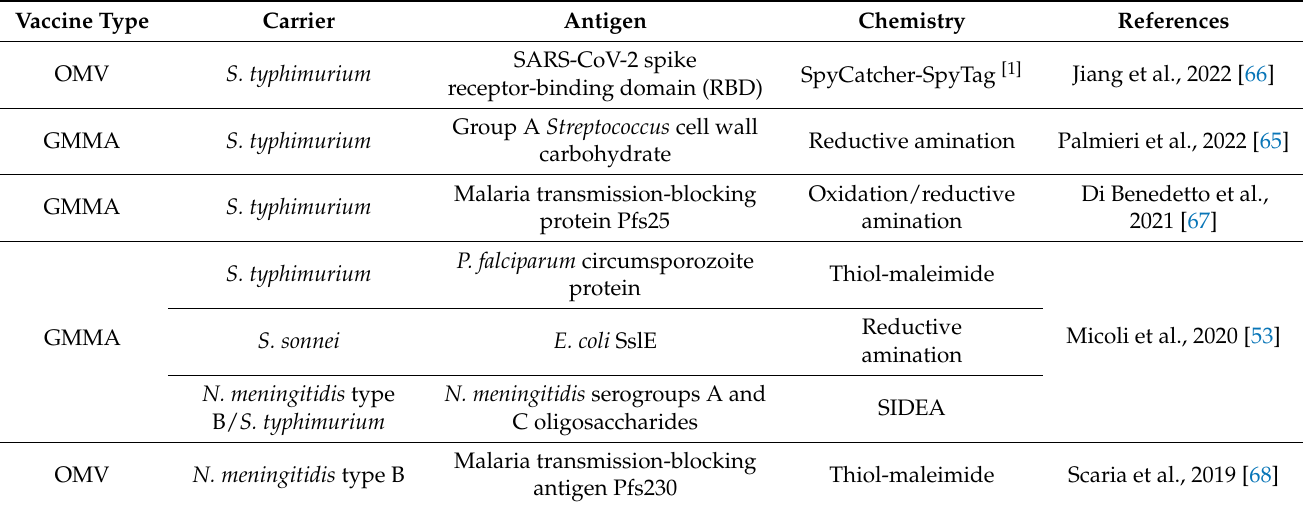
Table 1. OMV/GMMA conjugation